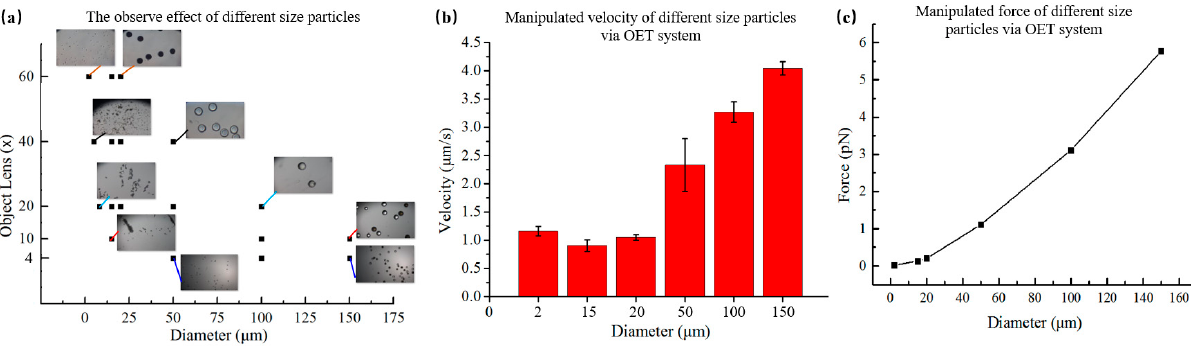
Figure 6. Manipulation velocity of particles with different sizes. ( a ) The observed effect of particles with different sizes through 4×, 10×, 20×, 40×, or 20× microscope objectives; ( b ) Manipulation velocity of particles with different sizes via OET system; ( c ) Manipulation force of particles with different sizes.